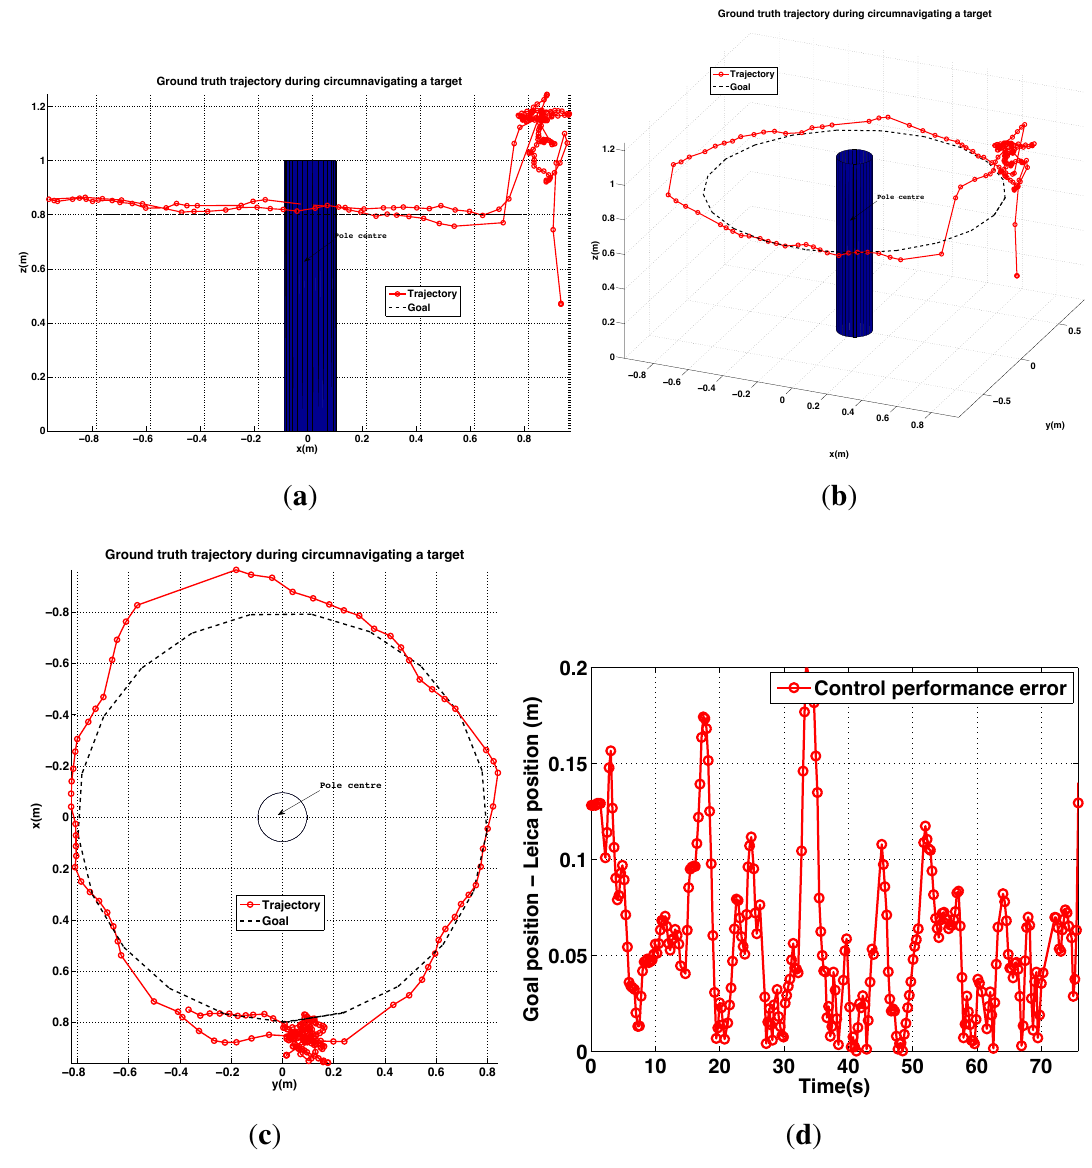
Figure 29. Experimental results for outdoor (day) PBVS-based circumnavigation: control performance. ( a – c ) 3D views of the trajectory: Side view, Perspective view and Top view; ( d ) Euclidean error (goal minus actual) trajectory versus